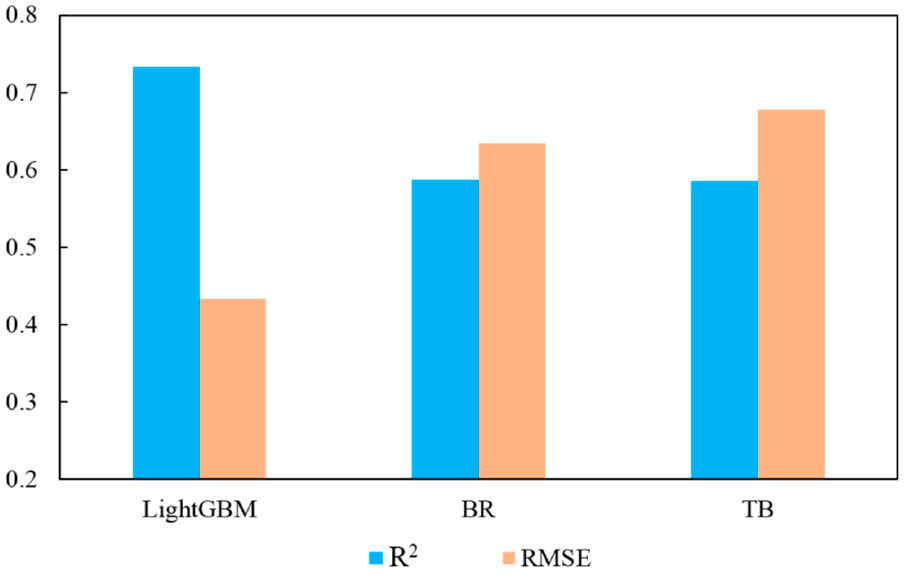
Figure 8. The average root-mean-square error (RMSE) and R 2 of chl-a concentration estimated using the LightGBM, blue-green band ratio (BR), and three-band (TB) models.